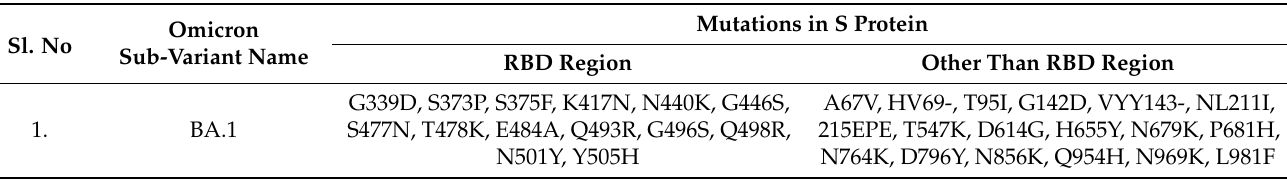
Figure 4. The figure shows different significant mutations in a 3D model of the S-glycoprotein of Omicron and its different sub-variants. ( A ) The figure shows different significant mutations in a 3D model of the S-glycoprotein of Omicron. ( B ) The figure shows different significant mutations in a 3D model of the S-glycoprotein of Omicron’s sub-variants, BA.1 and BA.2. Table 1. Omicron and its variants have several unique mutations in the RBD region. The RBD mutations might control the functionality of the RBD